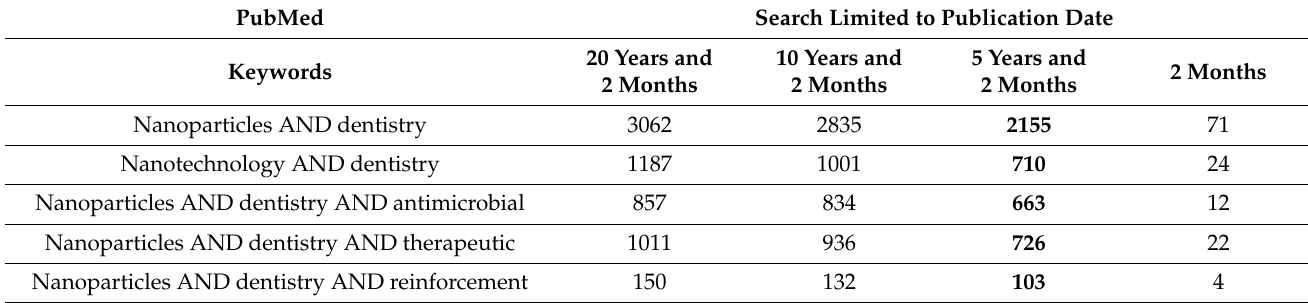
Table 2. Compilation of topic-related articles found in PubMed